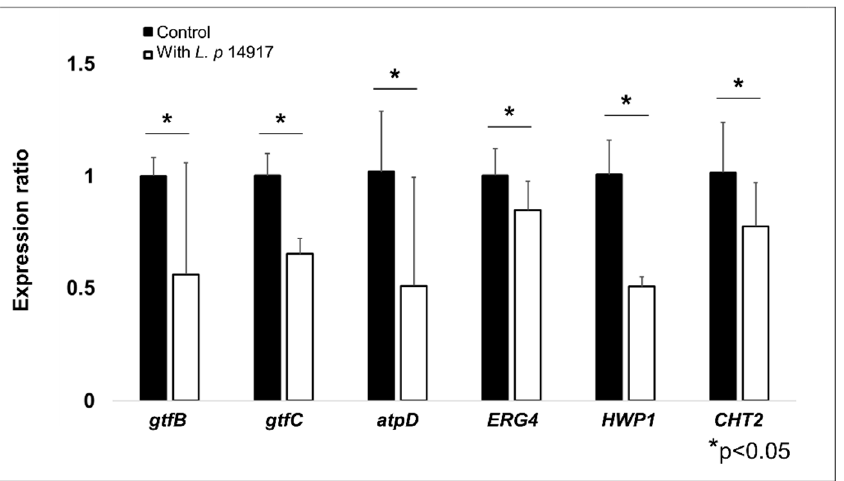
Figure 5. Regulation of S. mutans and C. albicans virulence genes by L. plantarum 14917 in multispecies biofilms. The expression of S. mutans ( gtfB , gtfC , and atpD ) and C. albicans ( ERG4 , HWP1 , and CHT2 ) genes related to carcinogenicity were reduced in the biofilms treated with L. plantarum 14917 for 50 h, compared to the control group ( S. mutans and C. albicans ). * p < 0.05 when comparing the control and L. plantarum 14917-treated biofilms.